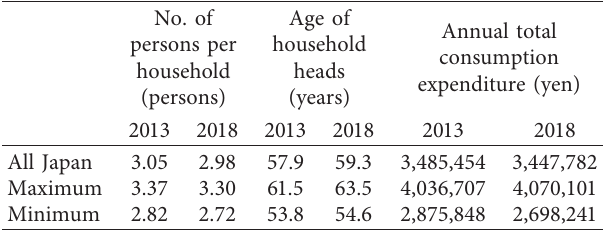
Table 1: Basic statistics for the 52 cities in FIES 2013 and 2018. No.